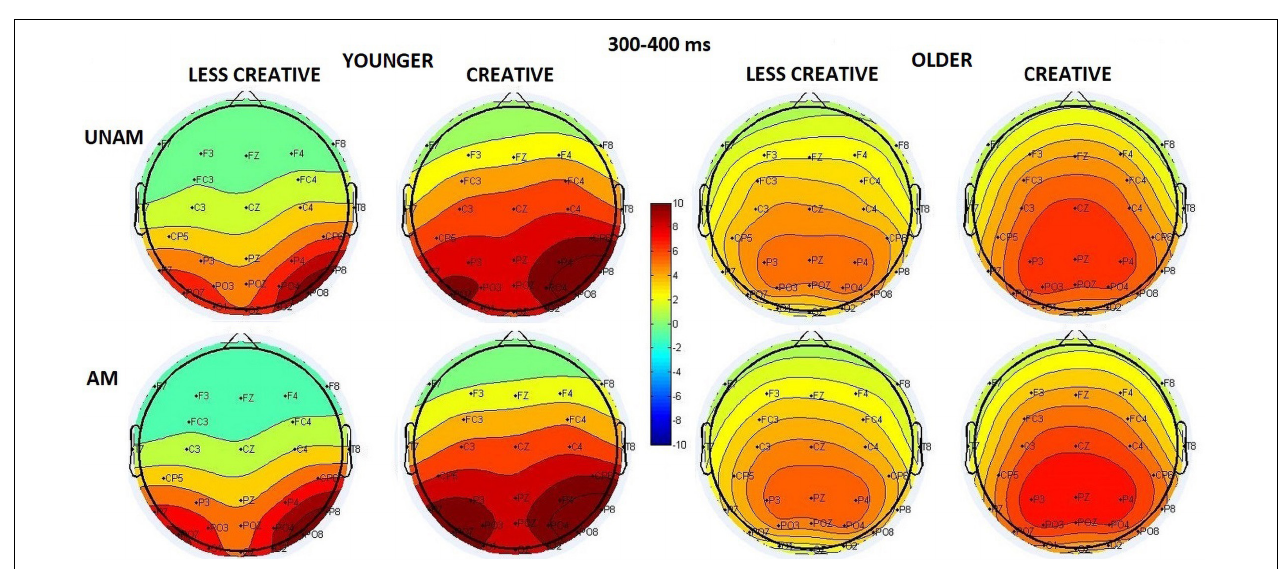
FIGURE 6 | Scalp distribution for the 300–400 ms range in the four groups (younger – less creative, younger – creative, older – less creative, older – creative) for unambiguous (UNAM, top row) and ambiguous (AM, bottom row)